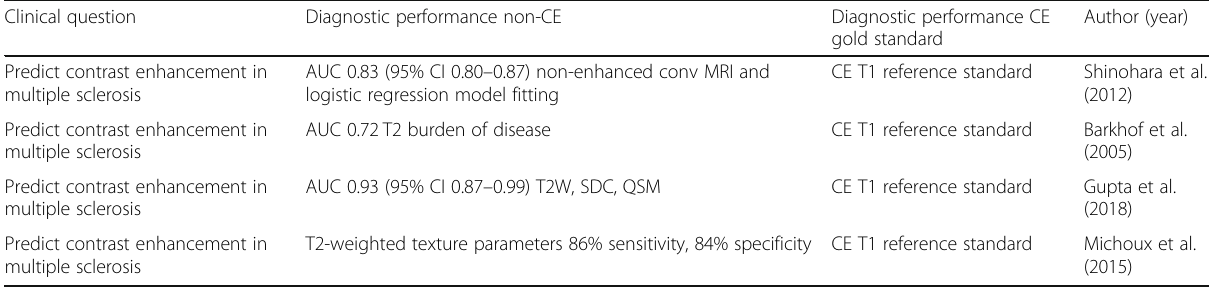
Table 2 Diagnostic accuracy measures in non-contrast-enhanced MRI techniques and contrast-enhanced techniques in multiple